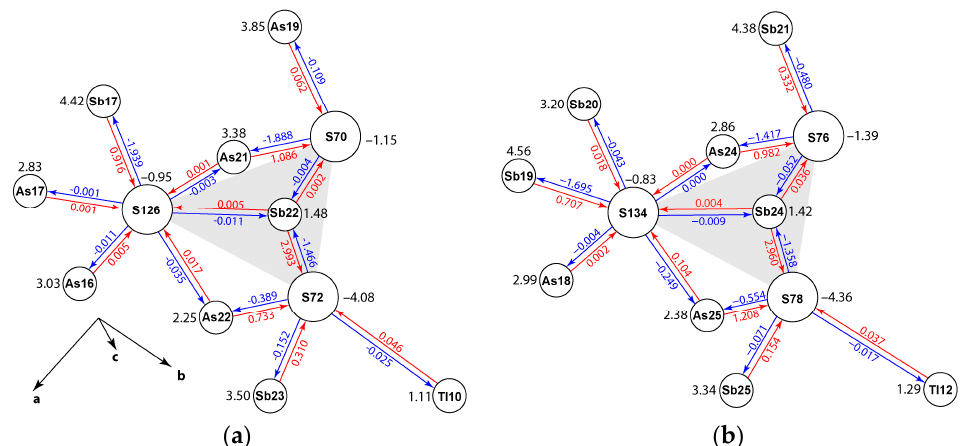
Figure 7. The charge distribution around Sb22 ( a ) and Sb24 ( b ) in the structure of dalnegroite (Bindi et al. [18]). Red values represent fractions of central atom charge distributed to the ligands ( ∆ q Xij → A ) ; the blue values are the partial charges received by the central atoms ( ∆ Q ij ) . Shaded areas represent projections of the coordination trigonal pyramids built on the shortest distances of Sb22 and Sb24. An increase of the coordination radius threshold would have resulted in adding only zero − weight bonds to these polyhedra. The numbers near the atoms are the computed charges Q X and Q A to be compared with the formal oxidation numbers: +3 for As,Sb, +1 for Tl, and − 2 for S. In contrast to the underbonding pointed out by the CD, the 𝐵𝑉𝑆 (cid:3025) values associated with Sb22 and Sb24 are both very elevated (5.49 and 5.96 vs. 3.00). The reason behind this